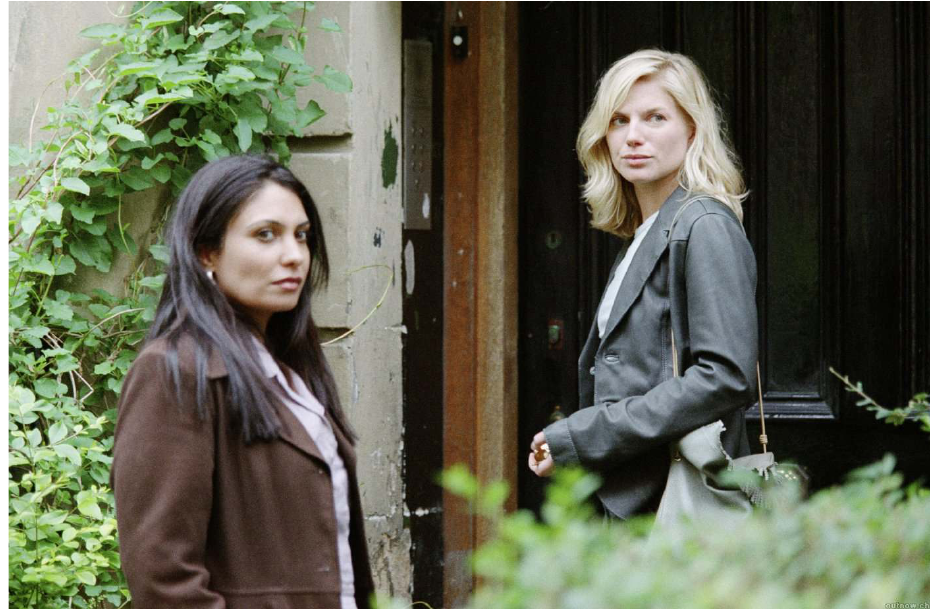
Rukhsana worries that her brother’s illicit relationship will jeopardize her own forthcoming wedding. Source: Ae Fond Kiss (dir. Ken Loach,